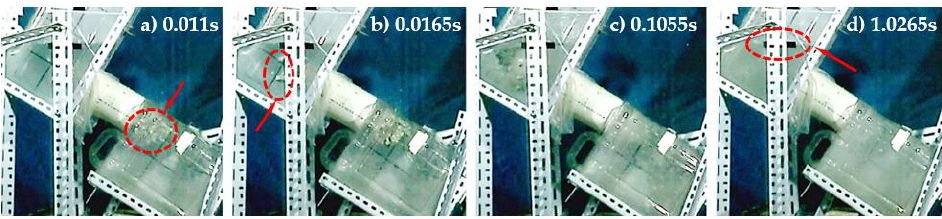
Figure 5. Process for experimental case 1 (β = 30°, h = 105 mm).